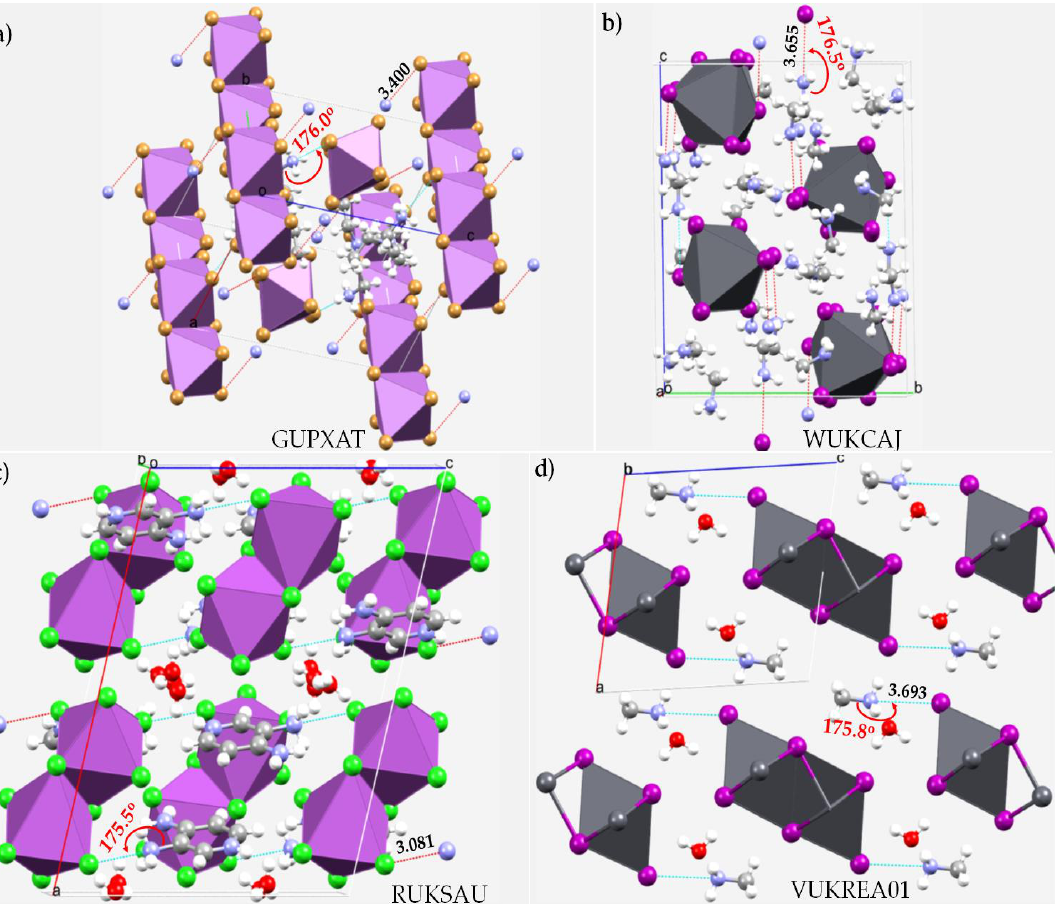
Figure 23. Ball-and-stick and polyhedral models of selected 1D structure. ( a ) bis(N 1 ,N 1 -diethylethane-1,2-bis(aminium)) bis( µ -bromo)-octabromo-di-antimony (C 6 H 18 N 22+ ) 2 (Br 10 Sb 24 − ) [154]; ( b ) pentakis(methylammonium) tris( µ -iodo)-hexakis(iodo)-di-lead bis(methylamine) (CH 6 N + ) 5 (I 9 Pb 25 − ),2(CH 5 N) [155]; ( c ) bis(3-ammoniumyl-4-amino-pyridin-1-ium) bis( µ -chloro)-octachloro- di-bismuth dehydrate (C 5 H 9 N 32+ ) 2 (Bi 2 Cl 104 − )2(H 2 O) [156,157]; ( d ) catena-[methylammonium bis( µ -iodo)-iodo-lead monohydrate (CH 6 N + )(I 3 Pb − ) n ,(H 2 O) [158]. Intermolecular contacts between bonded atomic basins are illustrated as dotted lines in cyan and hanging contacts in red. Selected bond distances and bond angles associated with the nitrogen-centered pnictogen bonds are in Å and degrees,